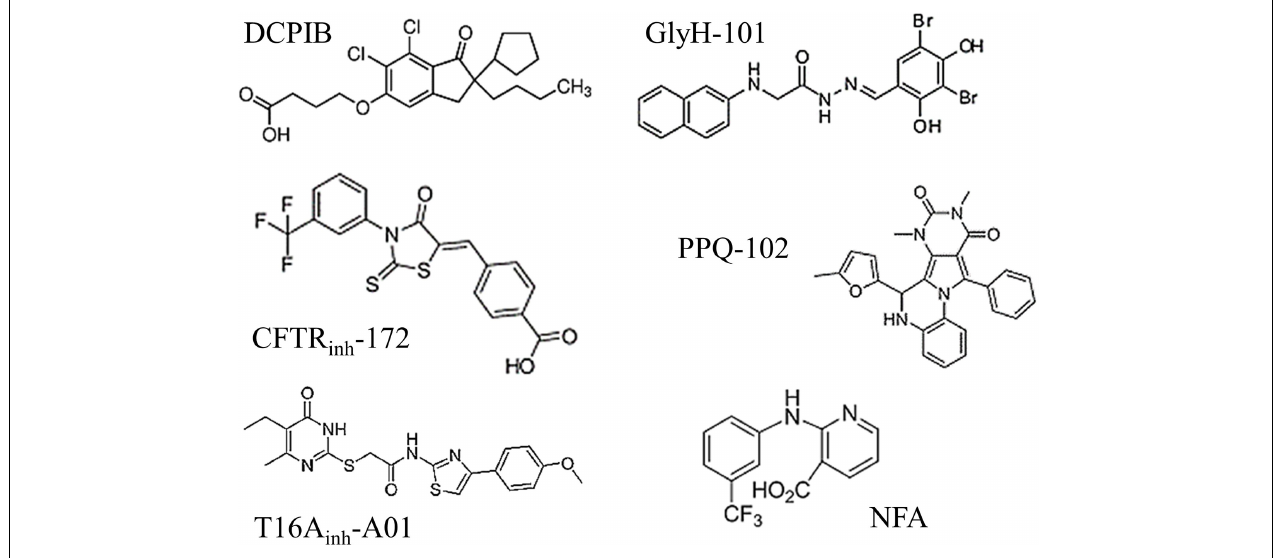
FIGURE 6 | Molecular structures of the six chloride channel inhibitors used in this study. Note that none of these drugs share any evident structural homologies. TABLE 1 | Effectiveness parameters of the six chloride channel inhibitors obtained from whole-cell experimental recordings and RVD experiments. Chloride conductance RVD